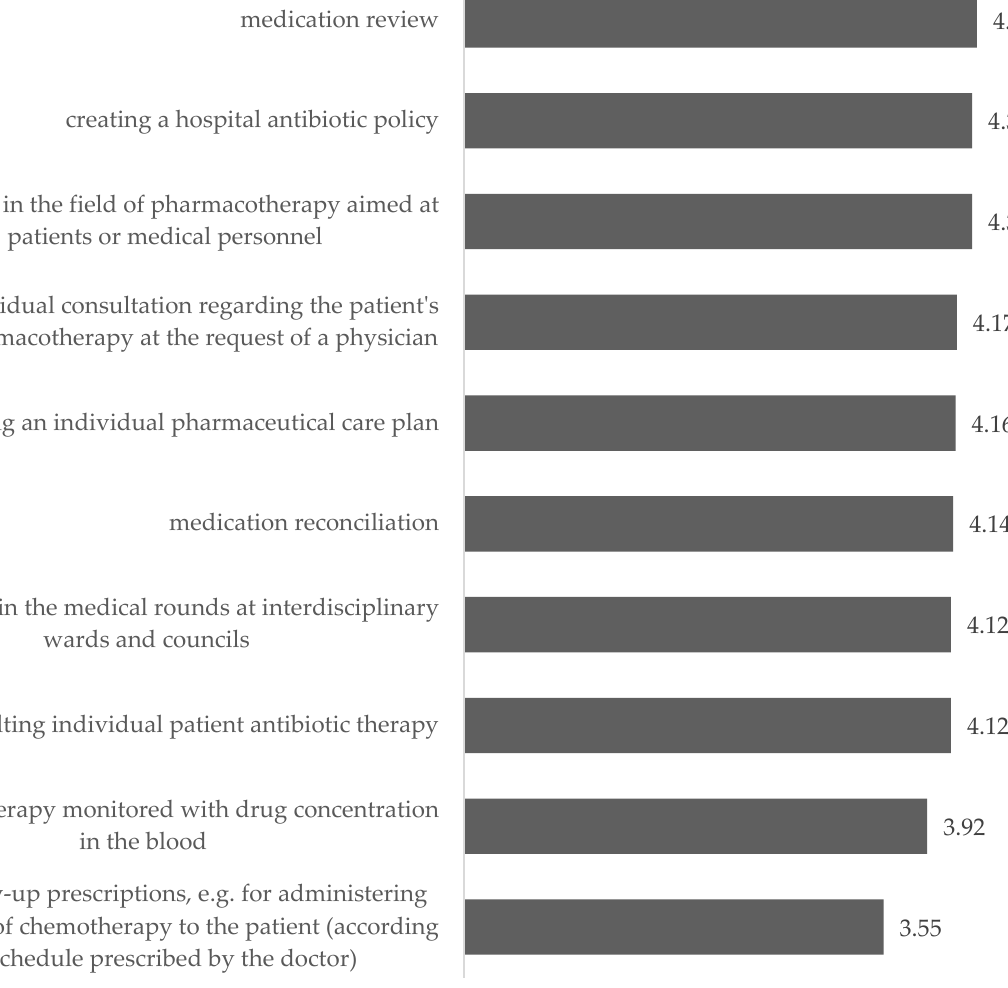
Figure 7. Assessment of the need to introduce clinical pharmacy services—mean.